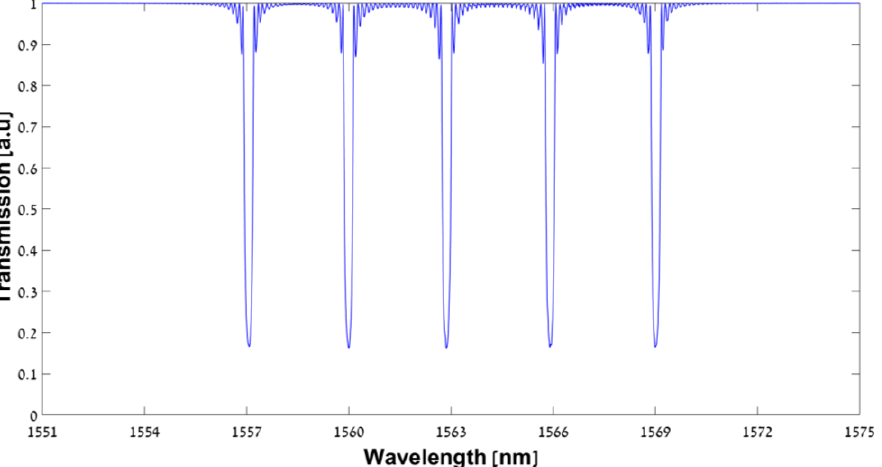
Figure 1. Calculated transmission spectrum of the complex structure, composed of five FBGs at different Bragg wavelengths, one on top of the other. The first Bragg grating wavelength is 1557 nm, followed by four others with a 3 nm separation between each two consecutive gratings. The transmission dip of each grating is ~80%.